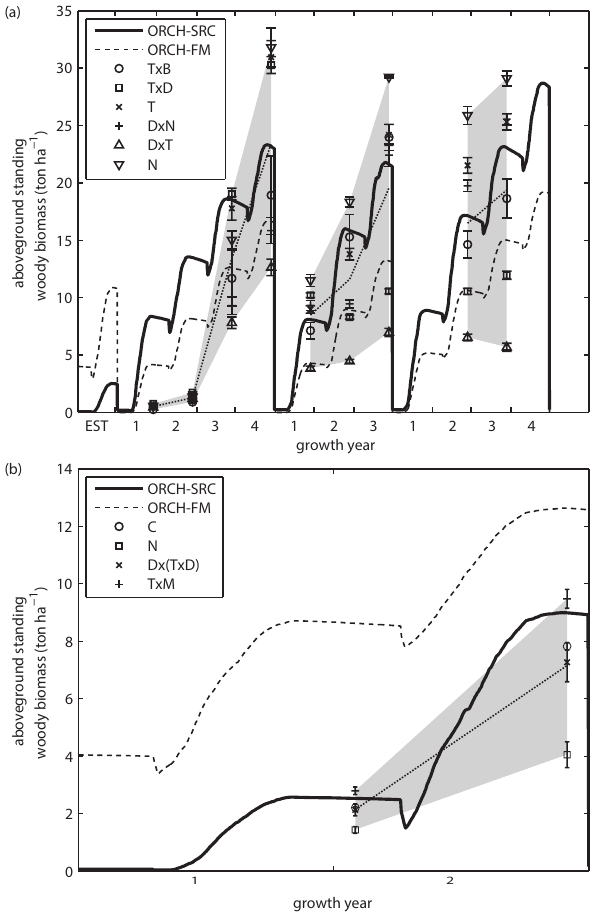
Figure 2. The simulated standing aboveground woody biomass (a) for the Boom site and (b) for the POPFULL site. The solid black line is the biomass simulated by the extended model, ORCHIDEE- SRC. The dashed line is the biomass simulated by the standard version of ORCHIDEE-FM, with only coppicing implemented. The symbols are the different parentages of the poplars at that site, and the grey area is the range of measured biomass. The parentages are Populus trichocarpa × P. balsamifera (T × B), P. trichocarpa × P. deltoides (T × D), P. trichocarpa (T), P. del- toides × P. nigra (D × N), P. deltoides × P. trichocarpa (D × T), P. nigra (N), P. canadensis (C), P. deltoides × ( P. trichocarpa × P. deltoides ) (D × (T × D)), and P. trichocarpa × P. maximowiczii (T ×